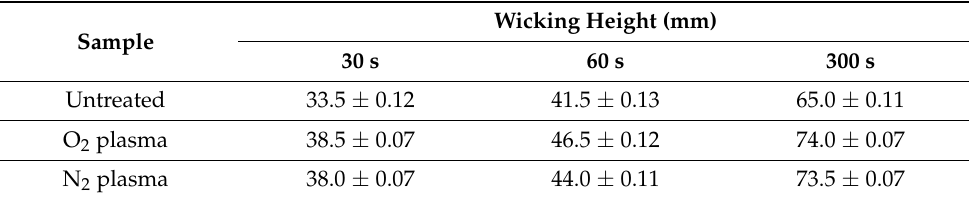
Figure 3. Wicking height (mm) of untreated and plasma treated samples after 30, 60, and 300 s. Table 2. Wicking height (mm) of untreated and plasma-treated cotton samples measured after 30, 60, and 300 s.